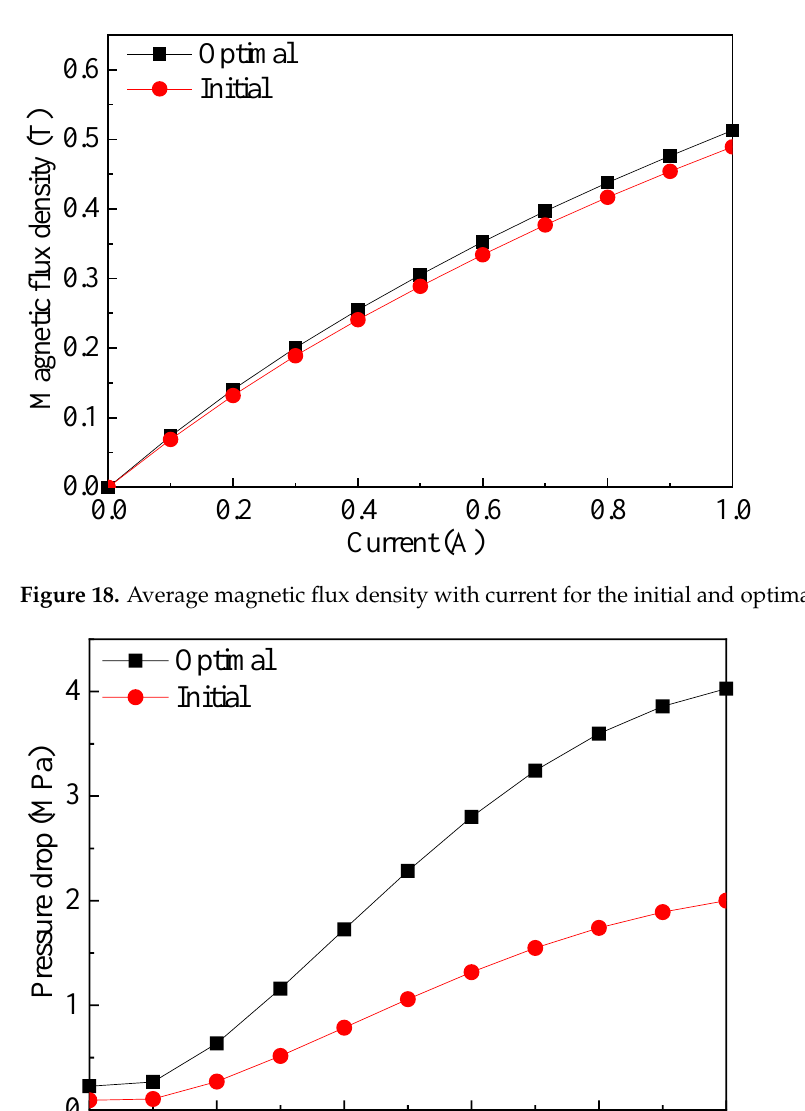
19 of 32 Table 2. Weight and sizes of the initial and optimal radial MR valve. Project